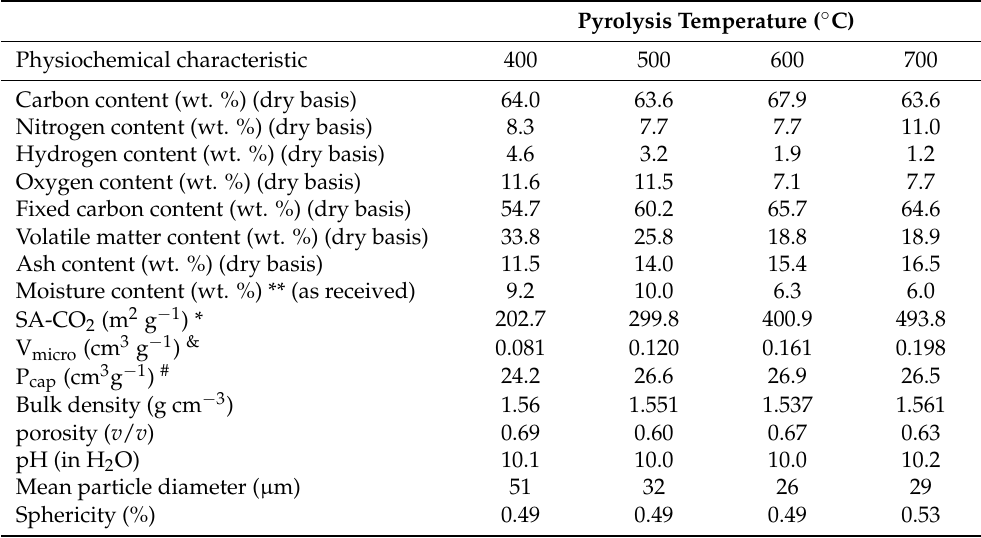
Table 1. A summary of the physiochemical characteristics of biochar types pyrolyzed at different temperatures &